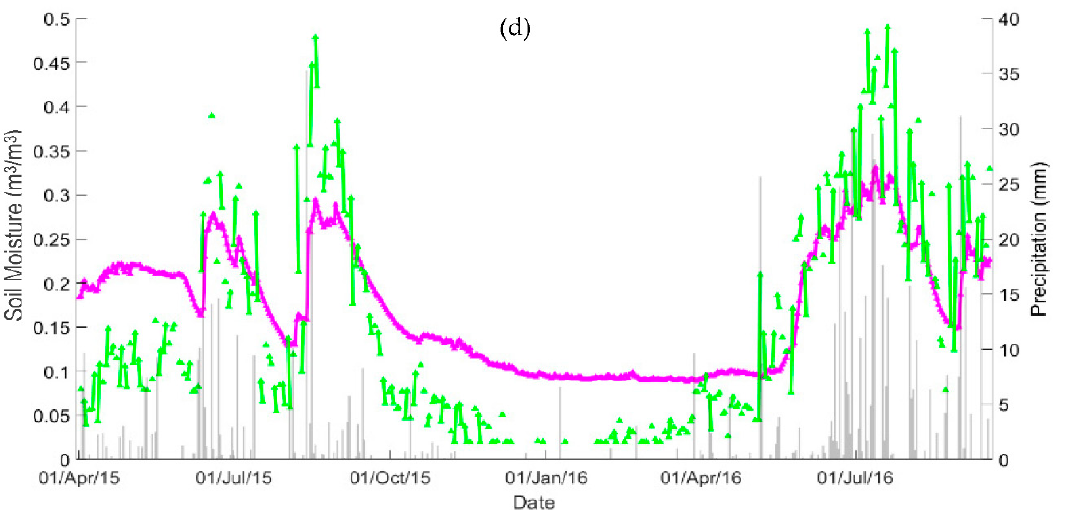
Figure 5. Temporal evaluation of station-averaged SSM (purple) and SPL3SMP_9km SSM (green): ( a ) Grid_34104, ( b ) Grid_34105, ( c ) Grid_34106, and ( d ) Grid_34107. The grey vertical lines repre- sent precipitation.